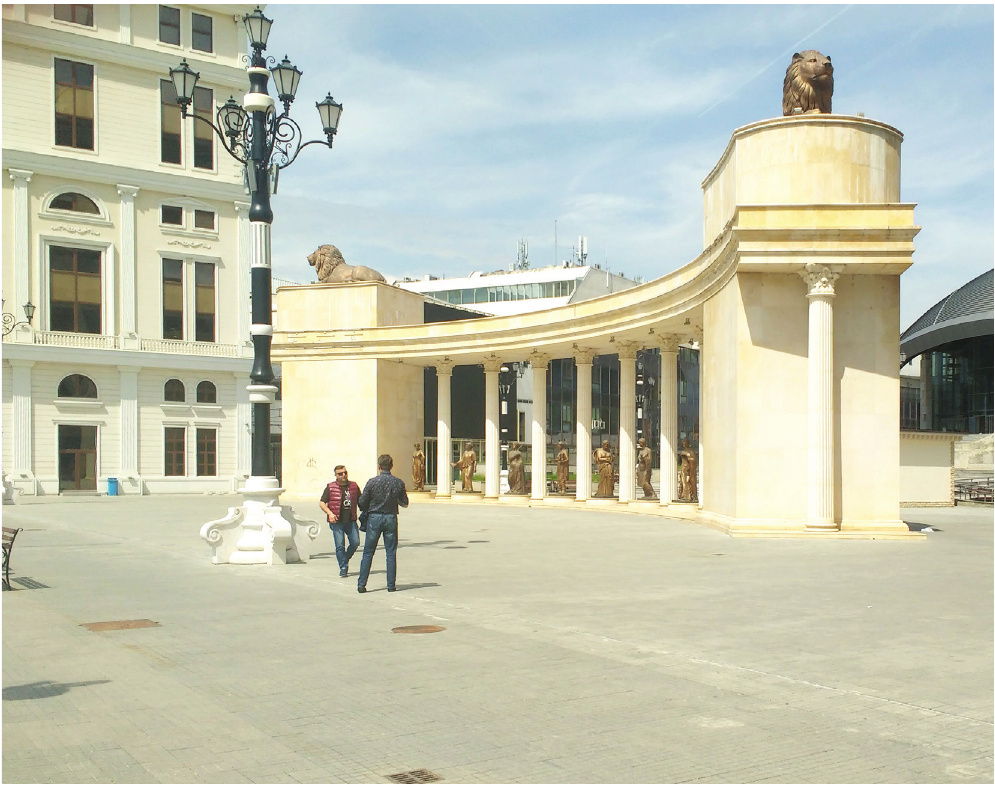
Figure 4 Giuseppe Resta,